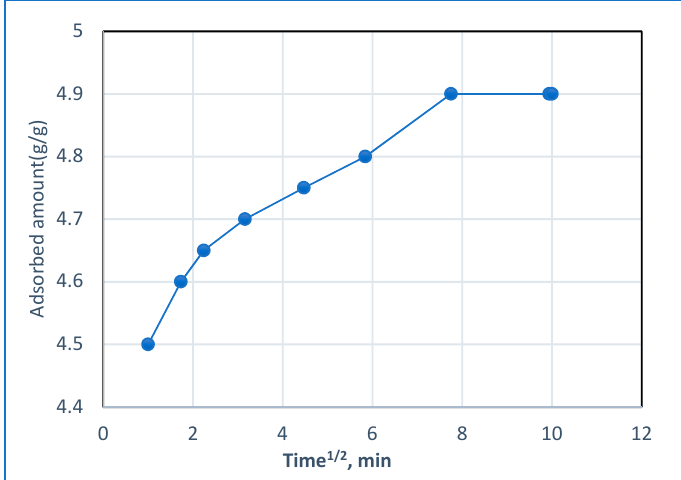
Figure 9. Adsorbed amount of BG dye onto Hap/CS nanocomposite as a function of the square root of time.